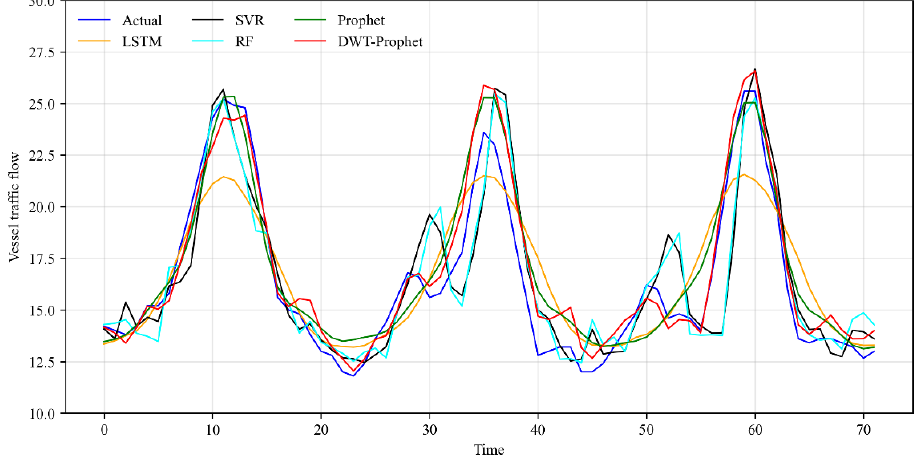
Figure 10. Comparison results of the actual and predicted values of the five models.